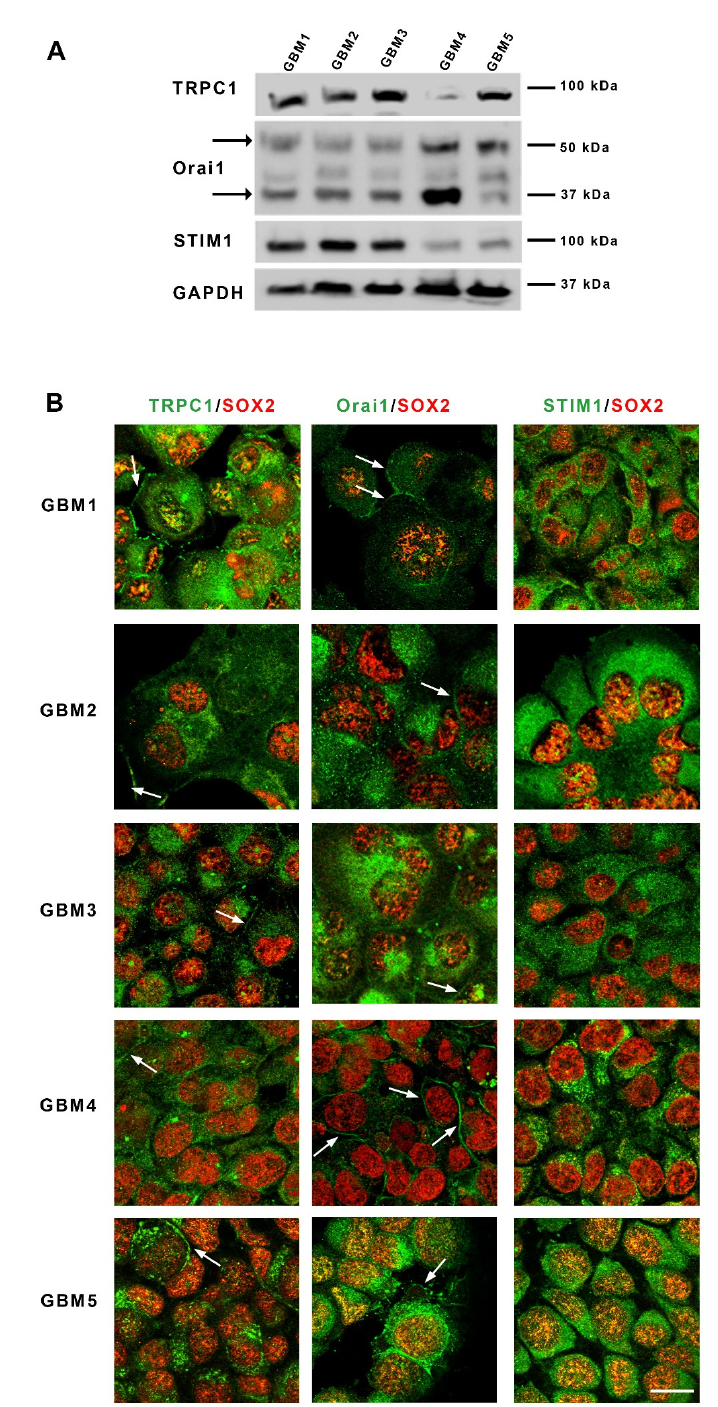
Figure 1. Glioblastoma stem cells express store-operated channels Orai1 and TRPC1 and their activator STIM1. ( A ): Immunoblotting of TRPC1, Orai1 and STIM1 proteins from five different primary cultures of GSC (GBM1-GBM5) derived from patients with GBM. Arrows point to the two bands obtained for Orai1 that correspond to the unglycosylated (37 kDa) or the glycosylated (50 kDa) form of Orai1. ( B ): Micrographs depicting co-labeling of TRPC1, Orai1 or STIM1 (green) with SOX2, a stem cell marker (red), in the five GBM cultures. Arrows indicate the membrane localization of the labeling. Scale bar: 25 µ m. Abbreviations: STIM1, stromal interaction molecule 1; TRPC1, transient receptor potential canonical 1; kDa,